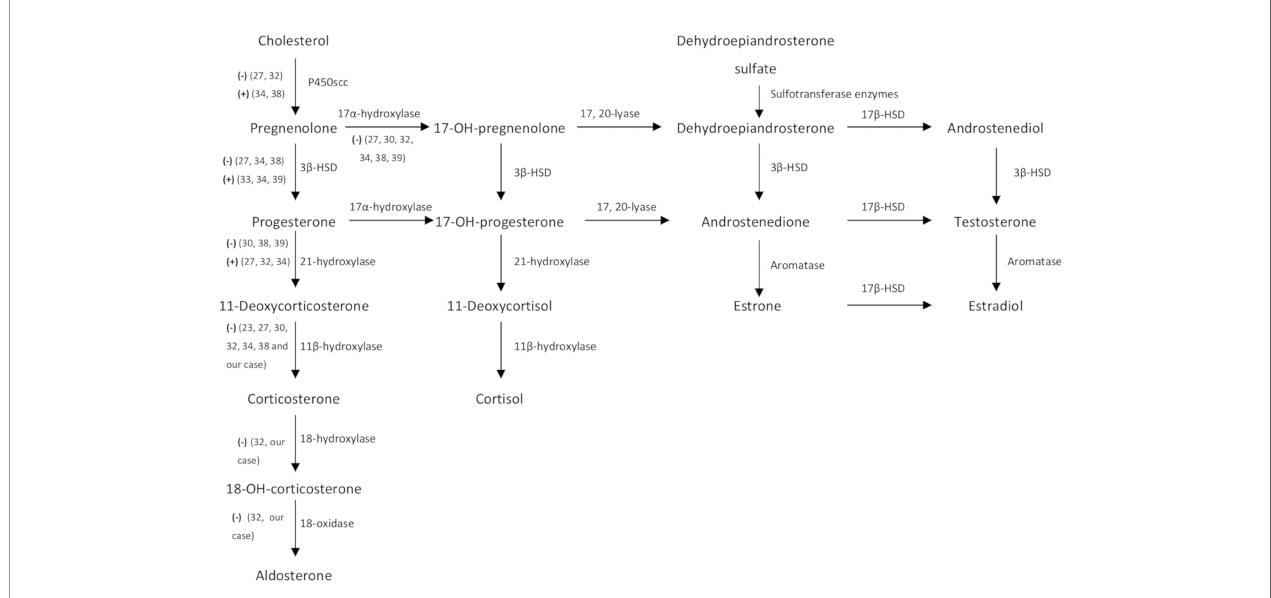
FIGURE 4 | Steroid hormone metabolism pathways. ( − ) and (+) represent diminished and increased enzyme activity respectively detected during intratumoral analysis of steroidogenic enzymes of nine case reports (including ours). 3 b -HSD, 3 b -hydroxysteroid dehydrogenase; 18-OH-corticosterone, 18-hydroxy- corticosterone; 17-OH-pregnenolone, 17-hydroxy-pregnenolone; 17-OH-progesterone, 17-hydroxy-progesterone, 17 b -HSD, 17 b -hydroxysteroid dehydrogenase.